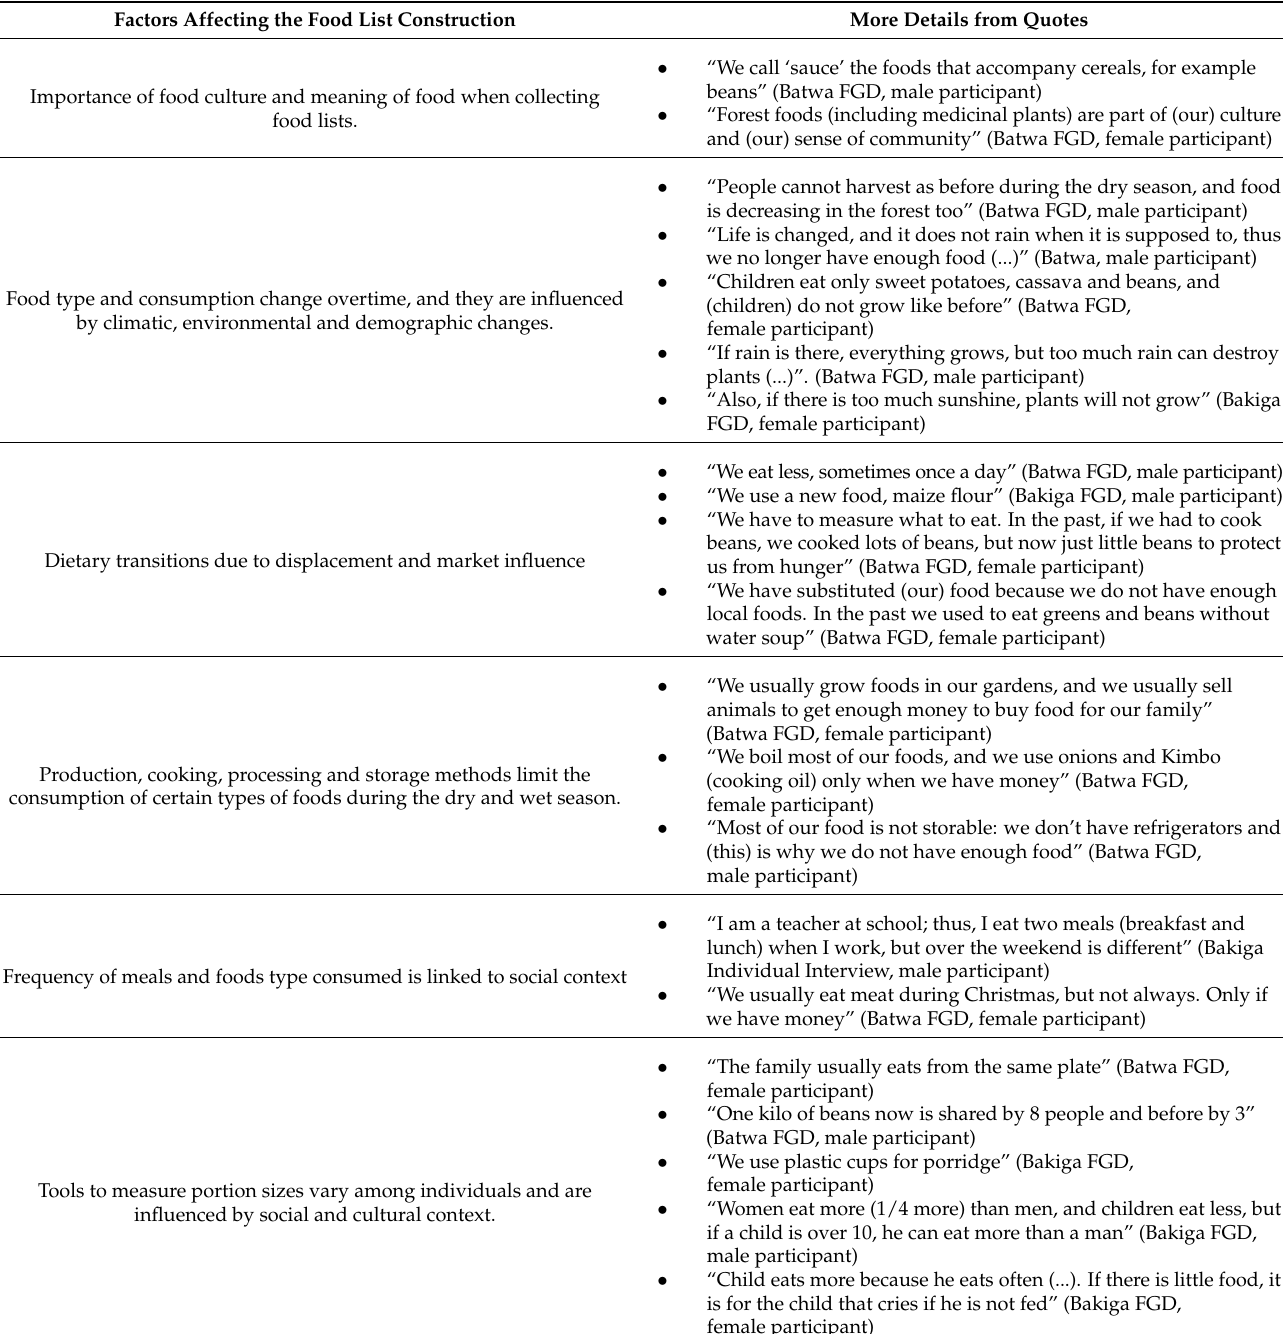
Table 3. Main qualitative findings of our study with associated quotes collected during the Batwa and Bakiga focus group discussions (FGDs) and individual dietary